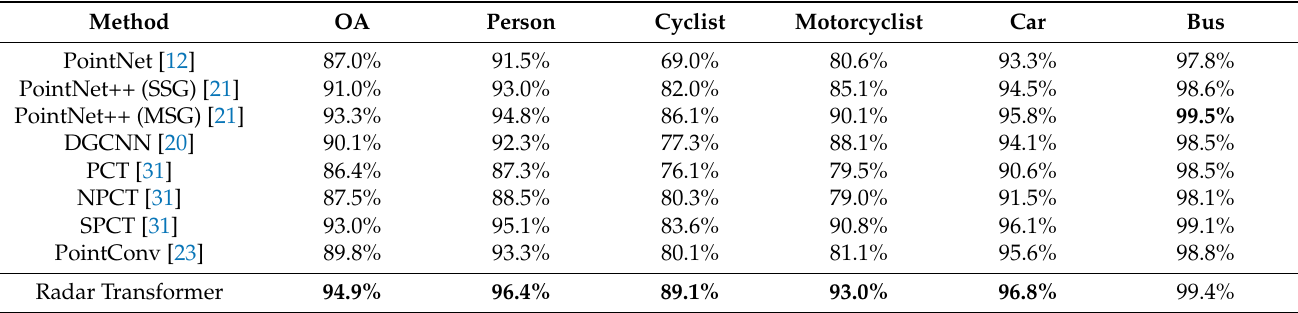
Table 2. Object classification results on our